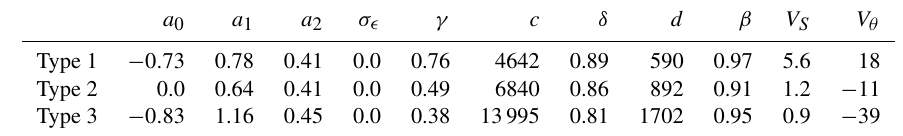
Table 1. Parameters of the stochastic rainfall model used for the generation of synthetic images.